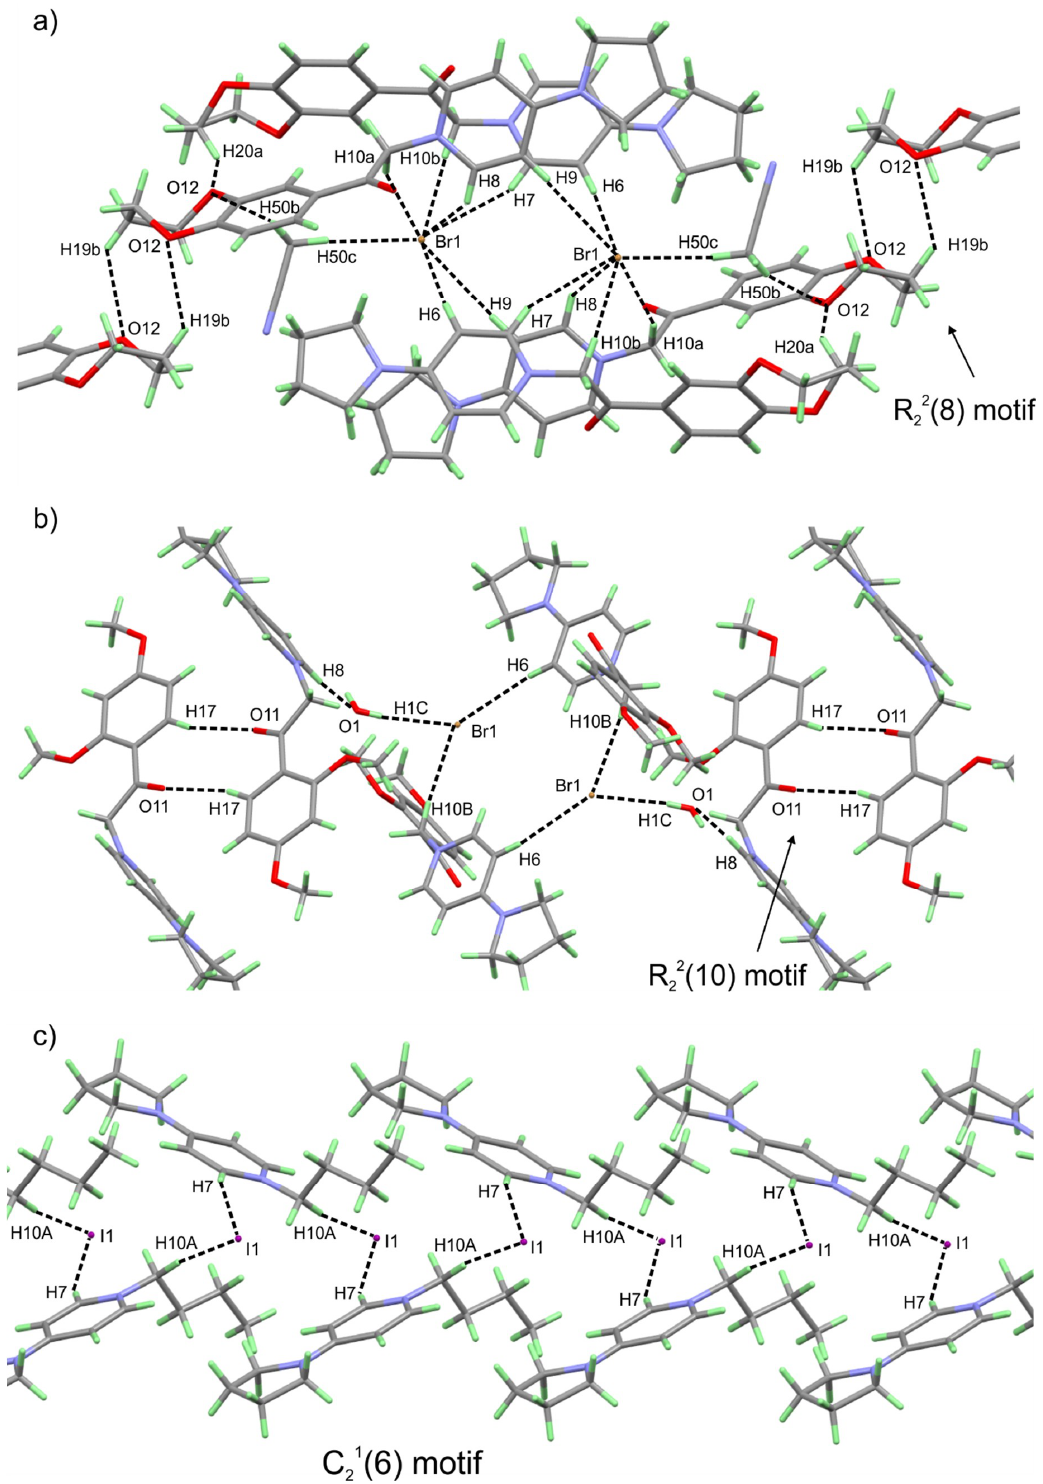
Figure 2. Halogen bonding interactions and short contacts for compounds 2 – ( a ), 3 – ( b ) and 6 – ( c ). The three-dimensional packing of the molecules of 2 , 3 and 5 reveals specific pairing of the halogen bonding interactions between the QASs molecules, forming R 22 (8), R 22 (10) and C 21 (6) motifs [43,44], respectively. The hydrogen atoms are given in light green for better visualization.